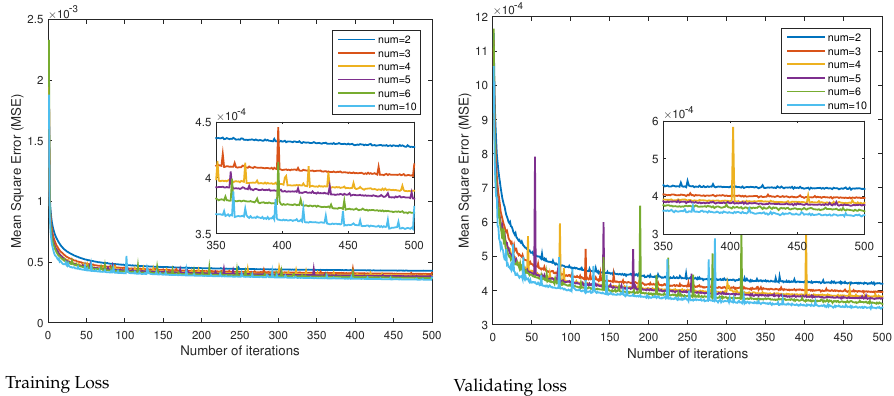
Figure 16. Convergence of different numbers of the PFFB structure: Training loss and validating